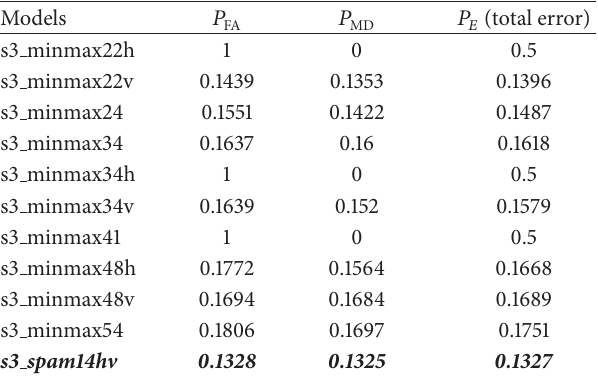
Table 3: Detection results of the third order submodels.